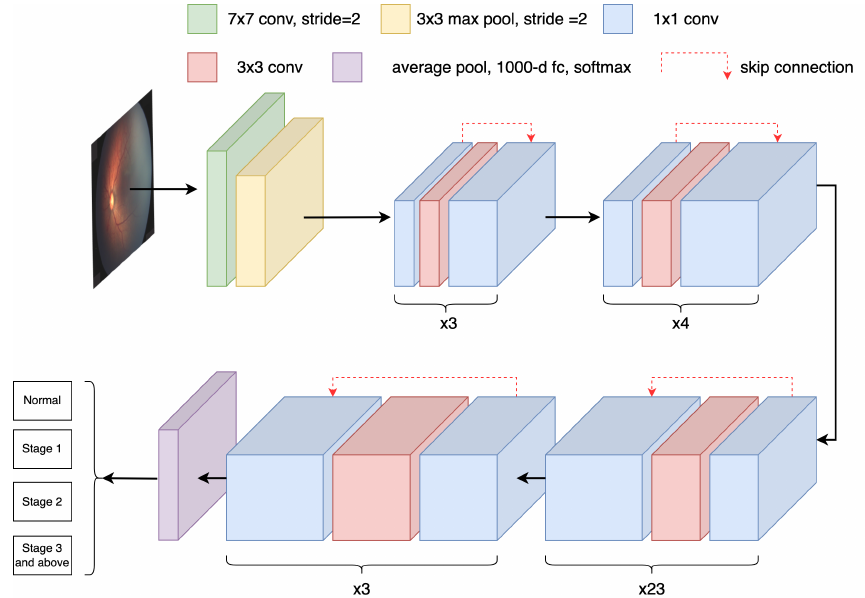
Figure 1. Architecture of a deep